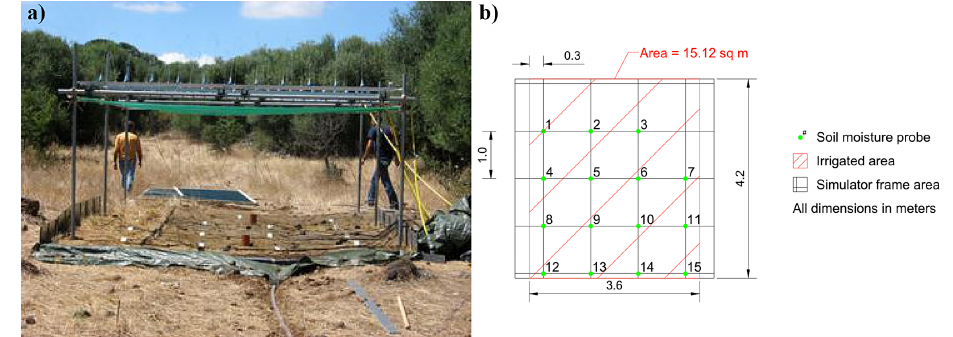
Figure 7. Field experiment setup. (a) Field setup, including soil moisture probes, border around edges, rain gauges, nozzles, distribution mesh, and collection system. (b) Details of the plot area, with soil moisture probe location and effective coverage area. The outlet of the plot is at probe 14.